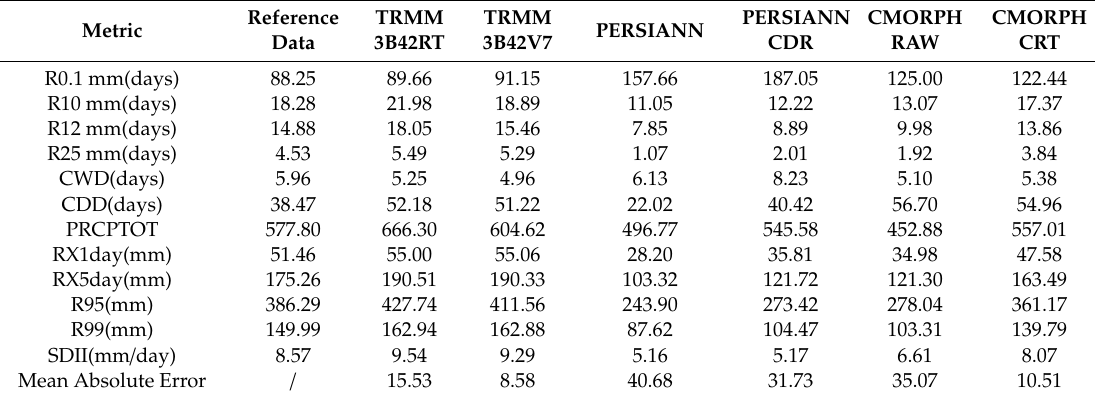
Table 5. Comparison of extreme precipitation indices for the reference data and the six